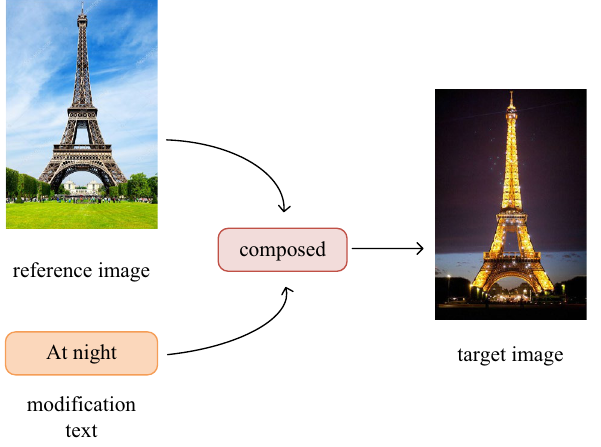
Figure 1. Example of image retrieval using reference image and text as query. (Created by ‘Microsoft Office Visio 2013’ https:// www. micro soft. com/ zh- cn/ micro soft- 365/ previ ous- versi ons/ micro soft- vision-